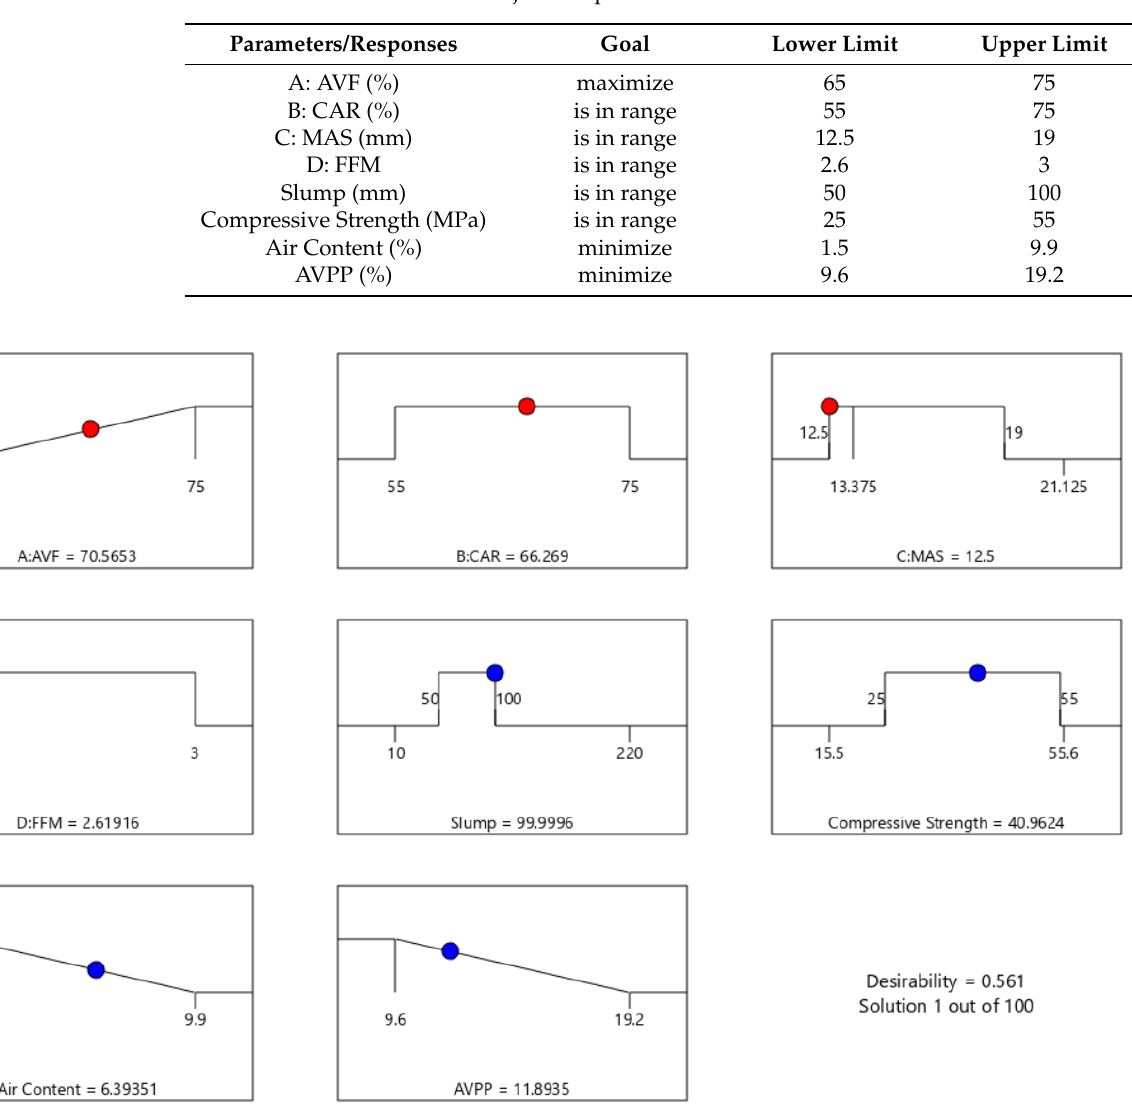
Figure 14. The ramps of the multi-objective optimized responses. Table 7. Mix proportions of the validation mixes.